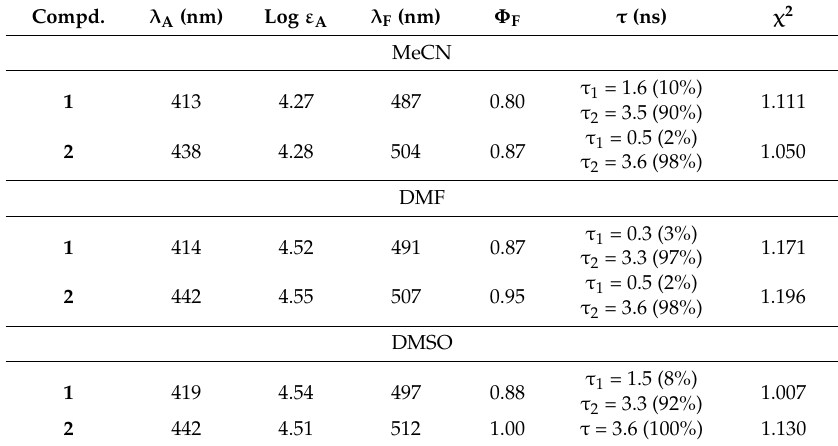
Table 1. Basic spectral characteristics of studied coumarin oximes 1 and 2 in MeCN, DMF and DMSO. Compd.